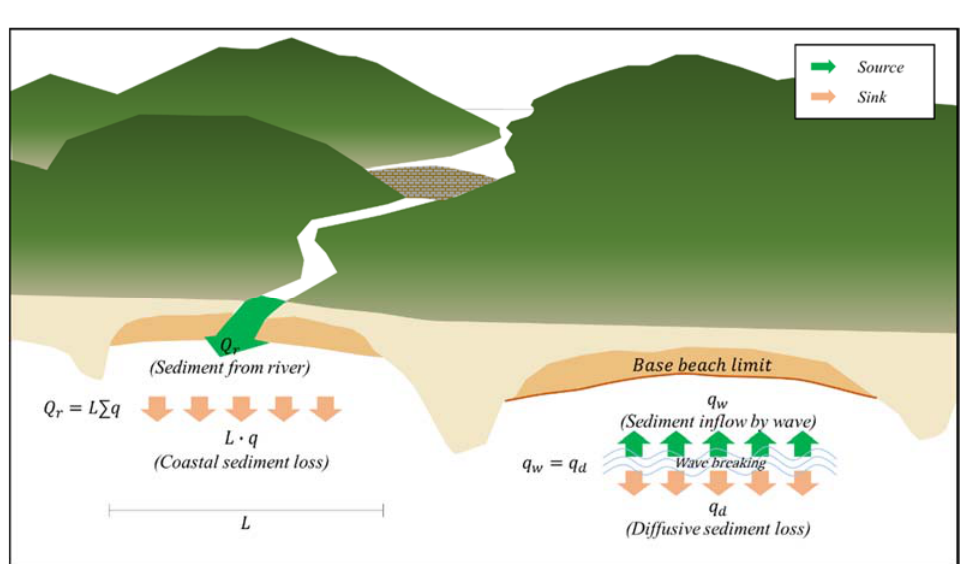
Figure 6. Conceptual diagram of source and sink of sediment in the sediment budget.